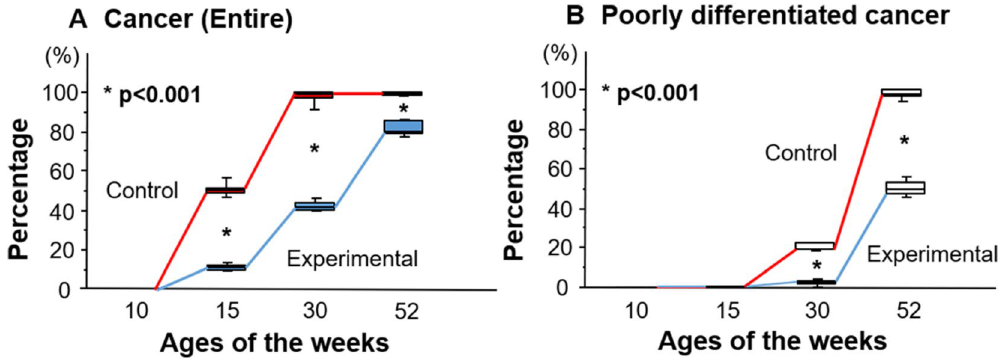
Figure 3. Percentage of cancer ( A ) and poorly differentiated cancer ( B ) at 10, 15, 30, and 52 weeks of age in control and experimental mice.